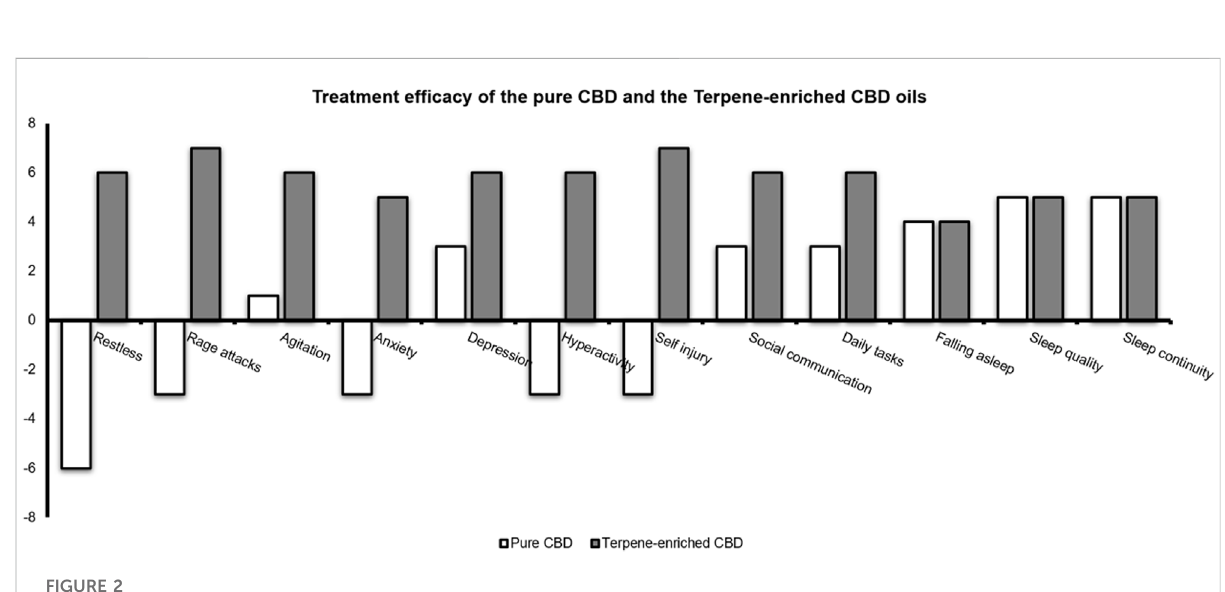
Table 1. Importantly, ef fi cacy was achieved at a CBD dose of less than a half the amount of CBD in pure CBD oil (0.19 mg/bw vs 0.48 mg/bw, respectively). Given the signi fi cant reduction in aggression, treatment with Tavor was reduced dramatically. In addition to the notable decrease in aggression, G ’ s parents report improved verbal capabilities, presented as increase in fl uent and spontaneous speech, as well as increased levels of humor.